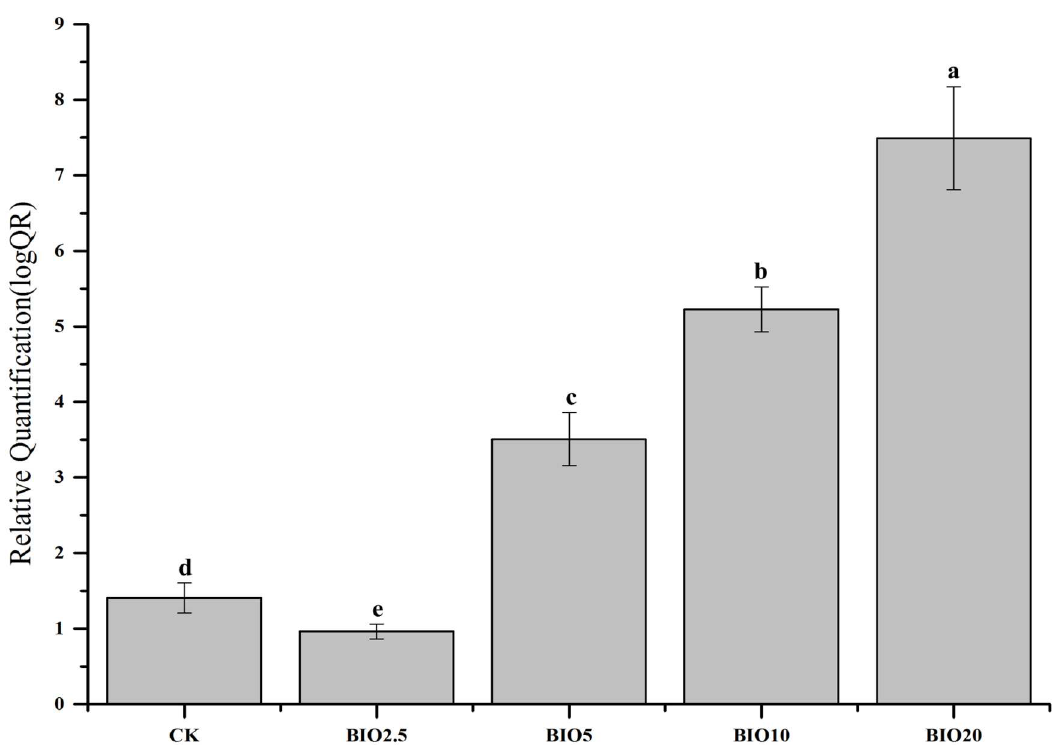
Fig 4. Real-time PCR relative quantification of B . subtilis SQR 9 in soils. Columnswith different letters are significantly different accordingto Duncan’stest ( p <